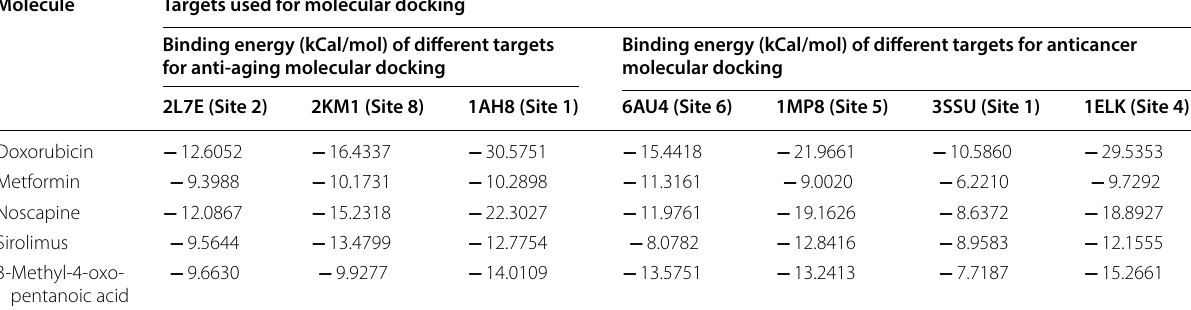
Table 2 Table representing comparison between binding energy of anti-aging and anticancer targets and to identify the probable mechanism of action Molecule Targets used for molecular docking